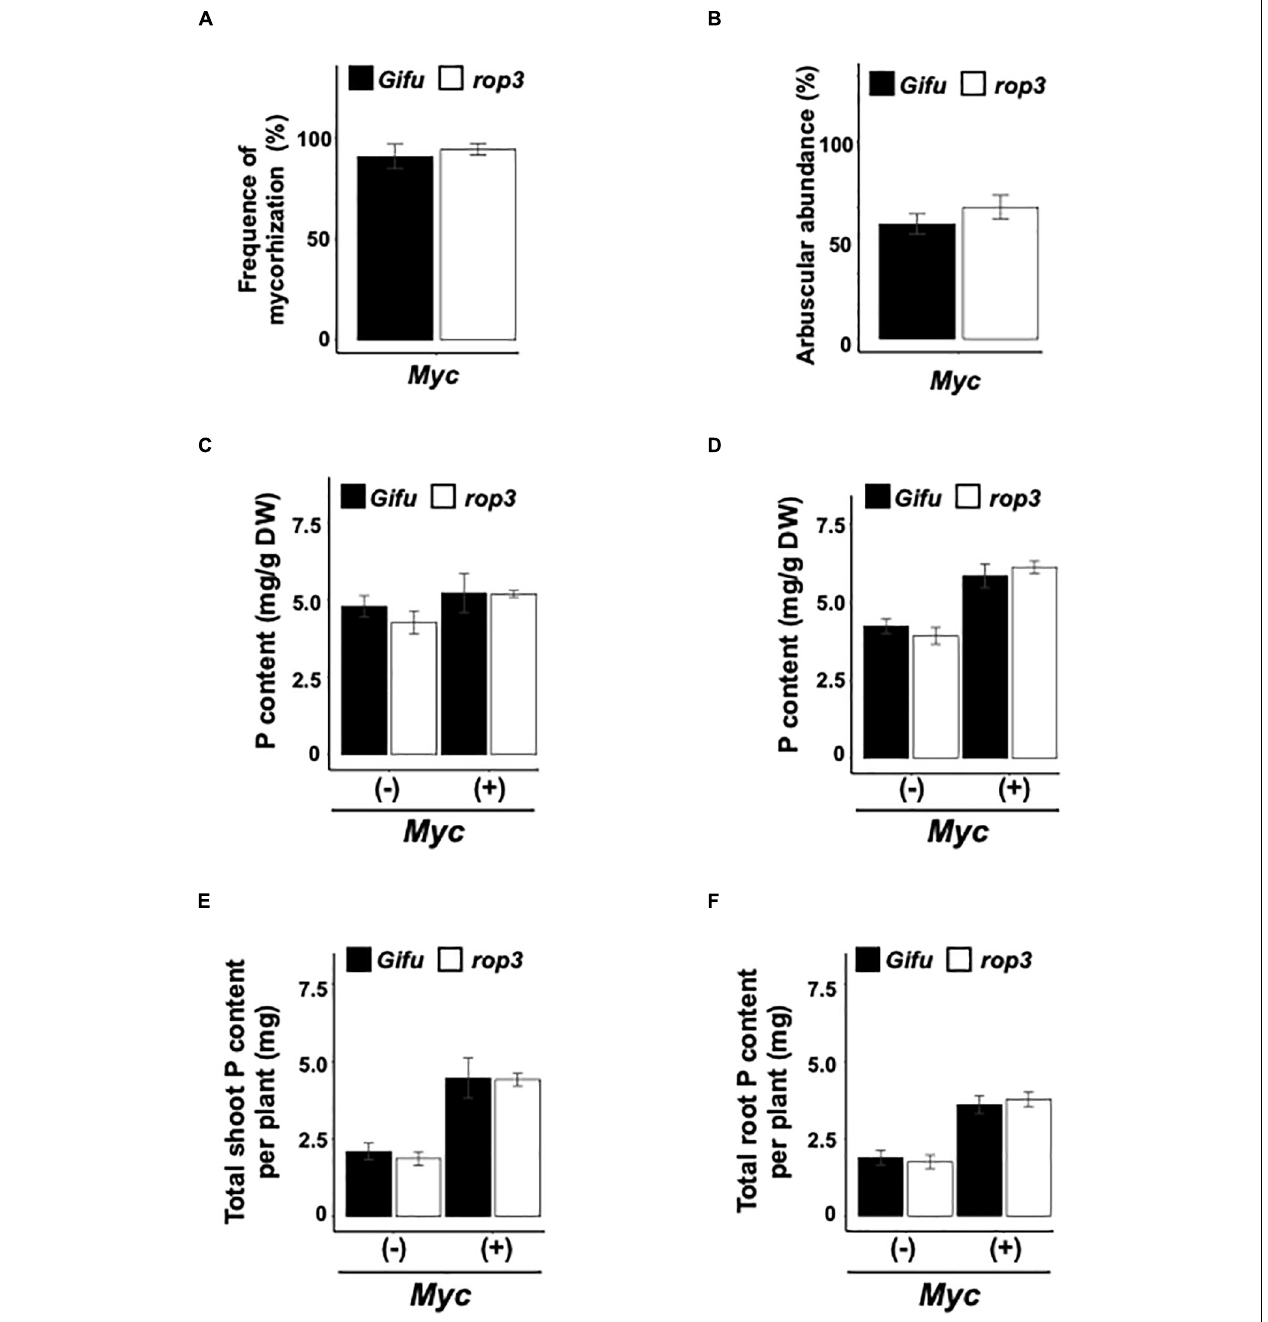
FIGURE 5 | Arbuscular mycorrhizal symbiosis is not altered in the rop3 mutant. (A) Frequency of mycorrhization, (B) arbuscular abundance, (C) phosphate contents in dried shoots, (D) roots, (E) total phosphate contents of shoots, and (F) roots were determined in Gifu wild-type and rop3 plants inoculated with R. irregularis . Bars represent mean values ( ± SD) of 3 independent experiments ( n = >